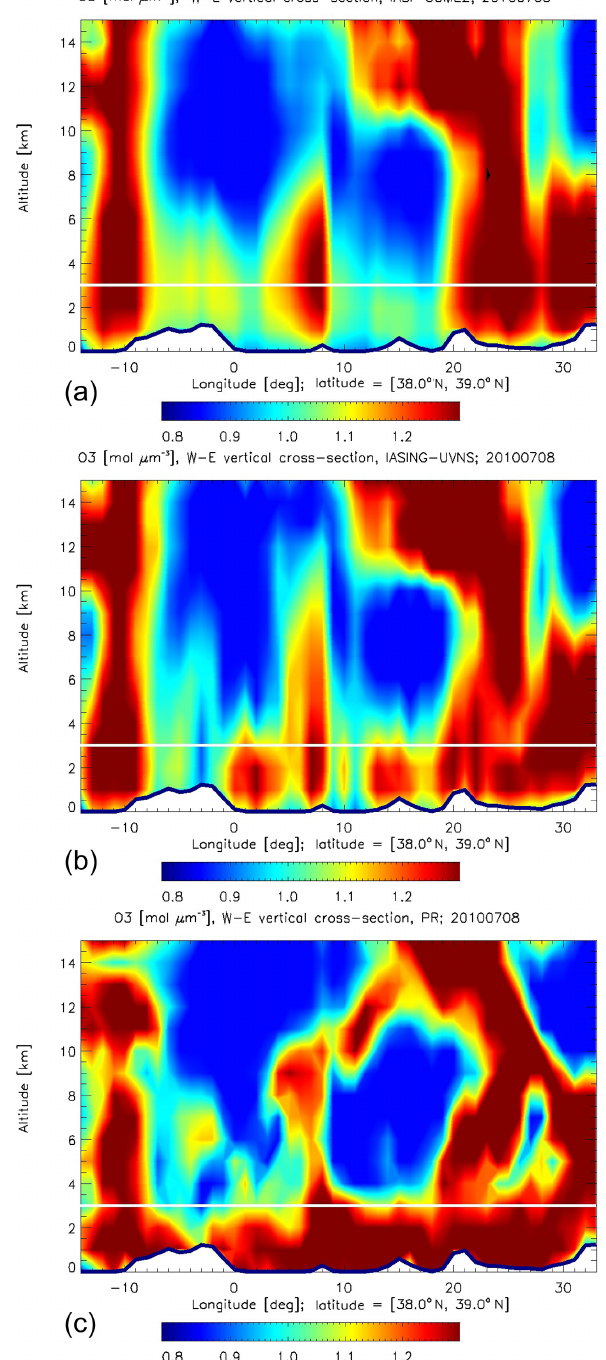
Figure 9. Cross section of ozone concentration [moleculesµm − 3 ] in the latitude band [38, 39 ◦ N] (as shown in Fig. 5, first row), from the surface to 15km altitude, for 8 July 2010. Data are av- eraged horizontally with a resolution of 1 × 1 ◦ . (a) IASI + GOME-2 retrievals. (b) IASI-NG + UVNS retrievals. (c) MOCAGE pseudo- reality. White line indicates an altitude of